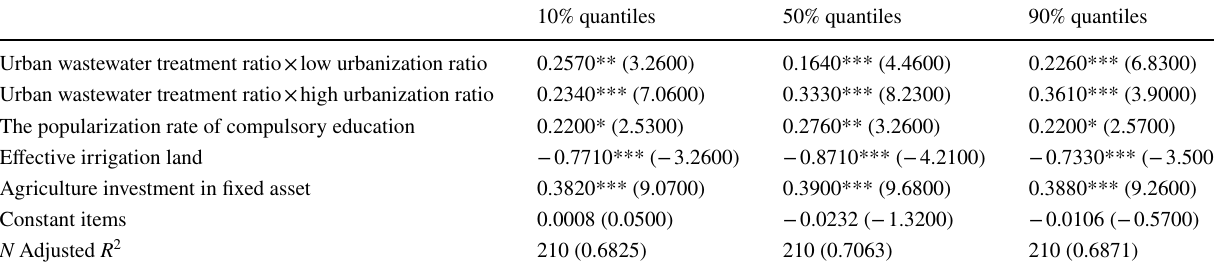
Table 6 Regression based on different urbanization ratio